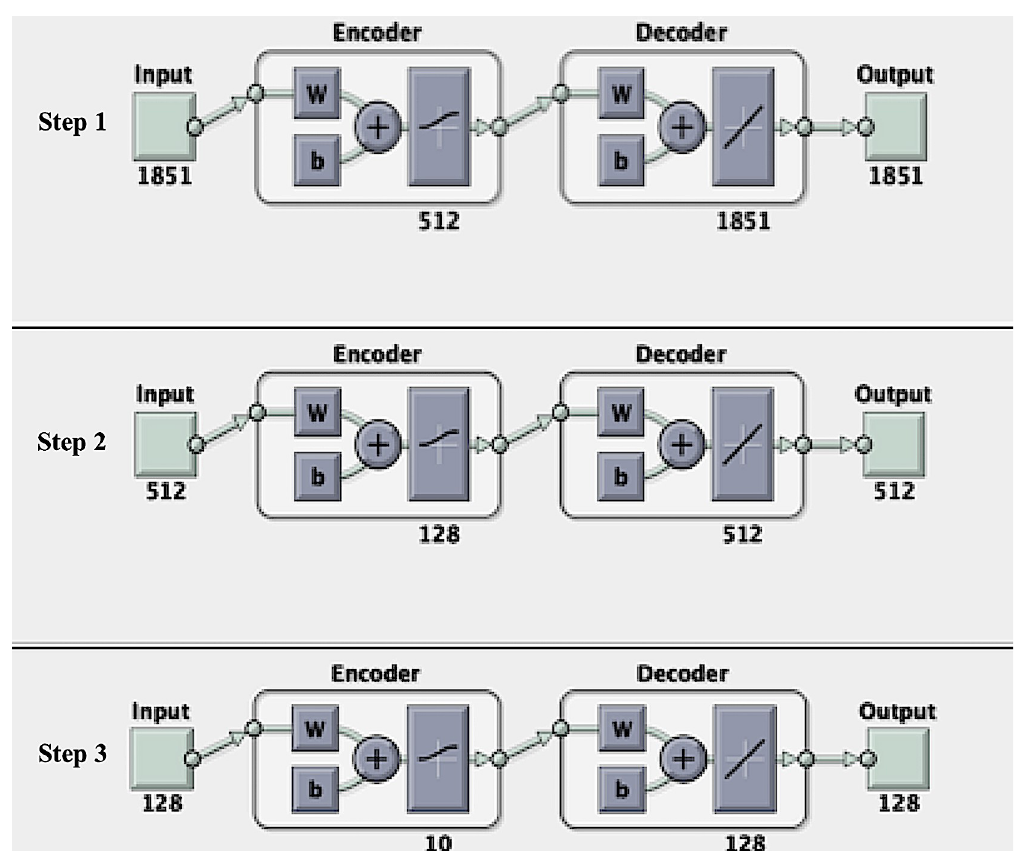
Fig 4. Reducing spectra feature space using an autoencoder and re-constructing original feature spaces from their respective encoded feature spaces (reconstruction accuracies presented in Table 1). Figures generated from MATLAB.